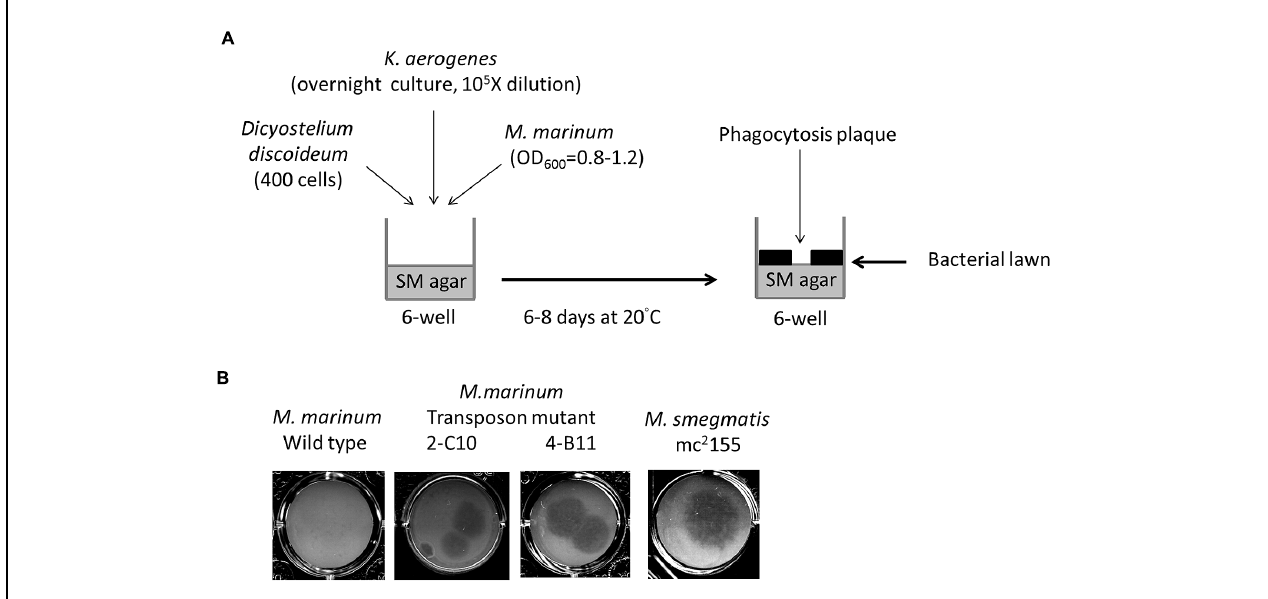
FIGURE 1 | Identification of Mycobacterium marinum genes for virulence using Dictyostelium. (A) Screening method of M. marinum NTUH-M6094 mutant library by Dictyostelium phagocytosis plaque assay. In six-well tissue culture plates containing SM agar, mid-log phase ( OD 600 = 0.8–1.2) cultured M. marinum and fresh overnight-cultured Klebsiella aerogenes (diluted 10 5 -fold) were mixed in normal saline and then air-dried. Four hundred Dictyostelium cells were then added on the top of the bacterial lawn. The plates were incubated at 20 ◦ C for 6–8 days until phagocytosis plaques became visible. (B) Dictyostelium phagocytosis plaques on the M. marinum M6094 wild type two transposon mutants and M. smegmatis . In presence of wild-type M. marinum M6094, Dictyostelium failed to form phagocytosis plaques. In contrast, a clear phagocytosis plaque was observed on bacterial lawn with M. smegmatis (avirulence mycobacteria). Two mutants 2-C10 and 4-B11 permit the formation of a clear phagocytosis plaque on the bacterial